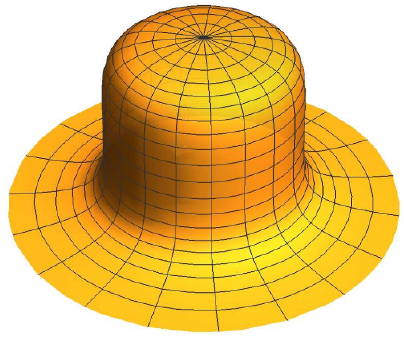
Figure 4 . A surface with a bulge which is cylindrical over some su(cid:14)cient distance and then closes o(cid:11). The distance function d ( X; Y ) 2 on this surface will have discontinuities in its (cid:12)rst